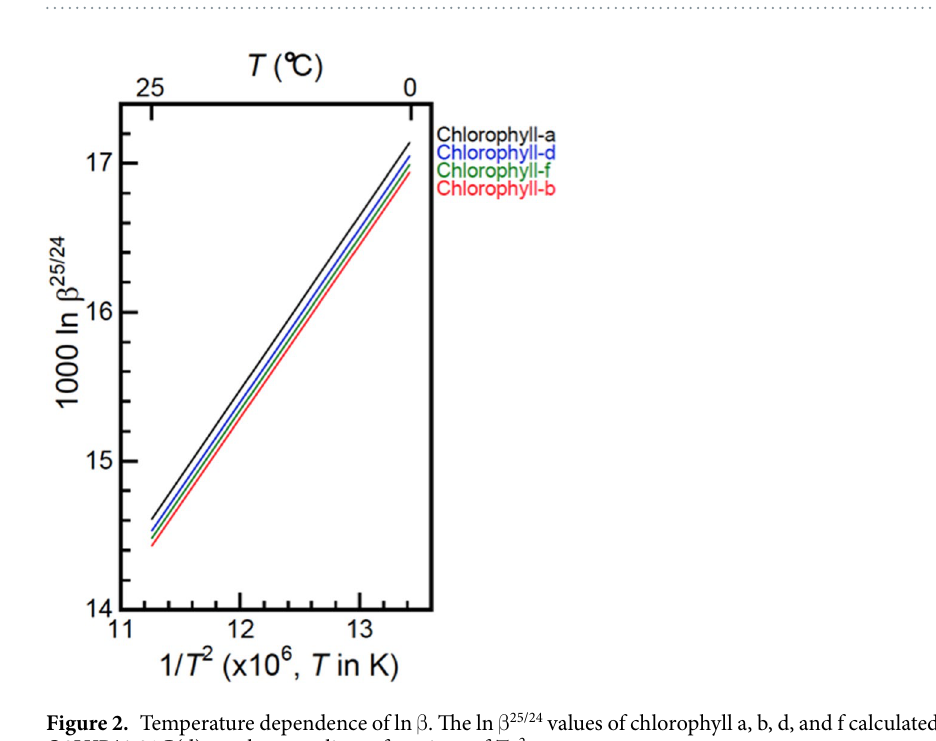
Table 3. Theoretical isotopic fractionation between different forms of chlorophylls and chlorophyll a for 298